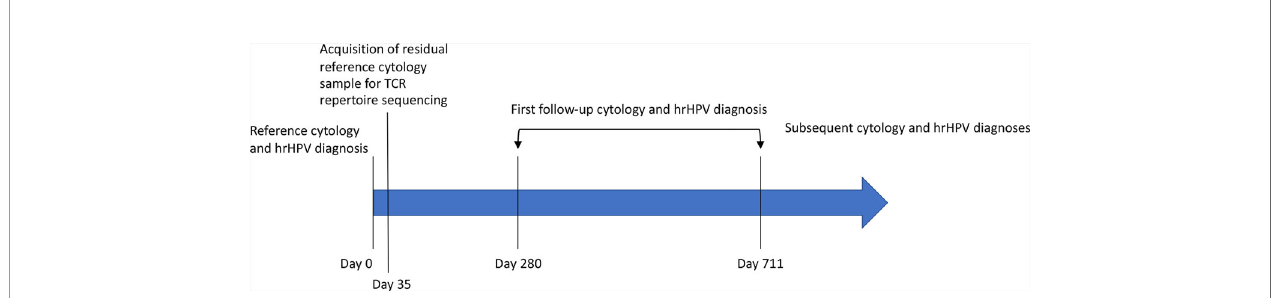
FIGURE 1 | The timeline of prospective follow-up diagnosis collection. Residual, standard-of-care cytology samples were rescued at the time of scheduled discard, fi ve weeks (35 days) after their collection and the completion of their use for clinical decision making. The associated cytology and hrHPV diagnoses constitute the patient ’ s reference diagnosis ( Table 1 ). These samples were used for HPV genotyping and TCR repertoire sequencing. The electronic health record was periodically checked for cytology, HPV, and pathology reports related to cervical cancer screening. Twenty-four women returned for follow-up screening 280-711 days after collection of the index sample ( Table 1 ). Seven of those women have returned for a second follow-up screening ( Table 1 ). The remaining women have not